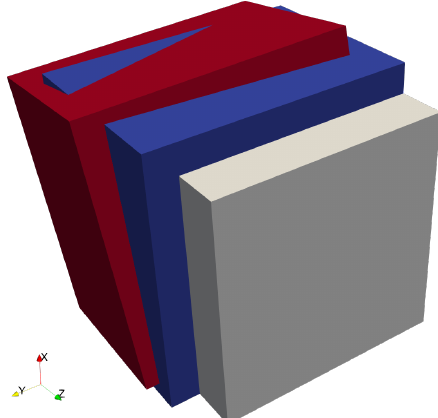
Figure 2. Schematic representation of the Bain strain, the related rotation and the total deformation. The application of B v (= B 3 ) (grey to blue) applies a compression along the Z axis and expansion in Y plane. The subsequent rotation R i (blue to red) is necessary to restore the habit plane as the X − unrotated and the in-plane direction